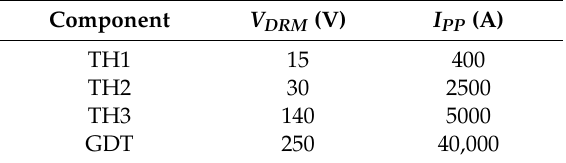
Table 1. Component specifications of the printed circuit board (PCB).